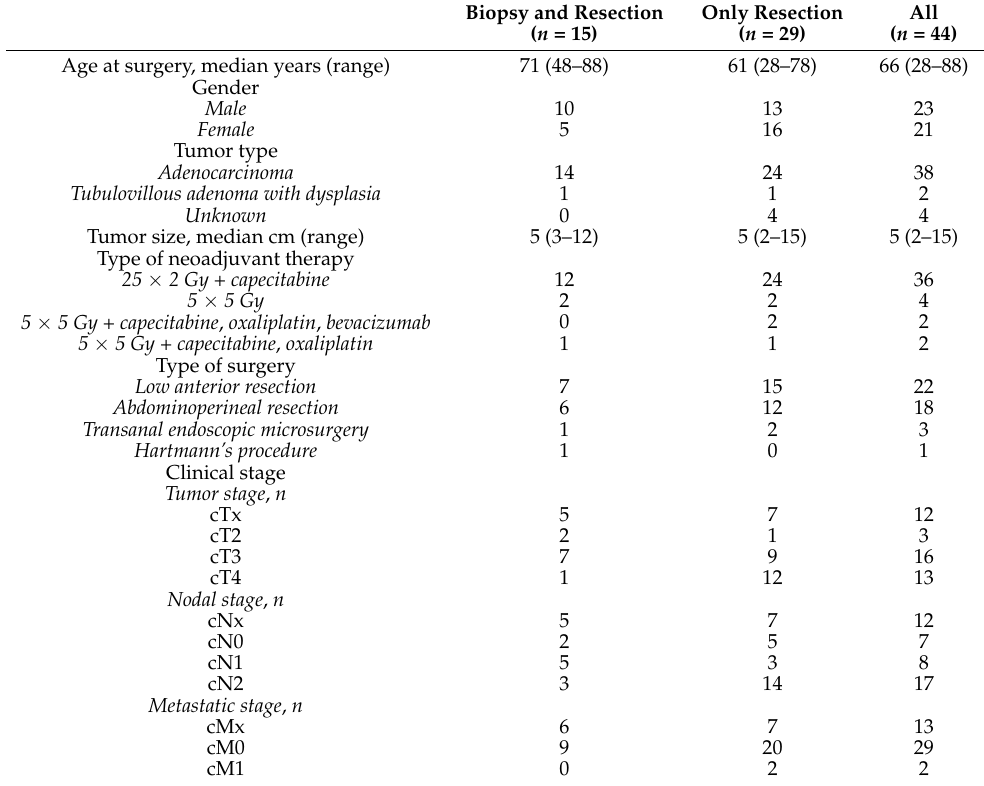
Table 1. Patient and tumor